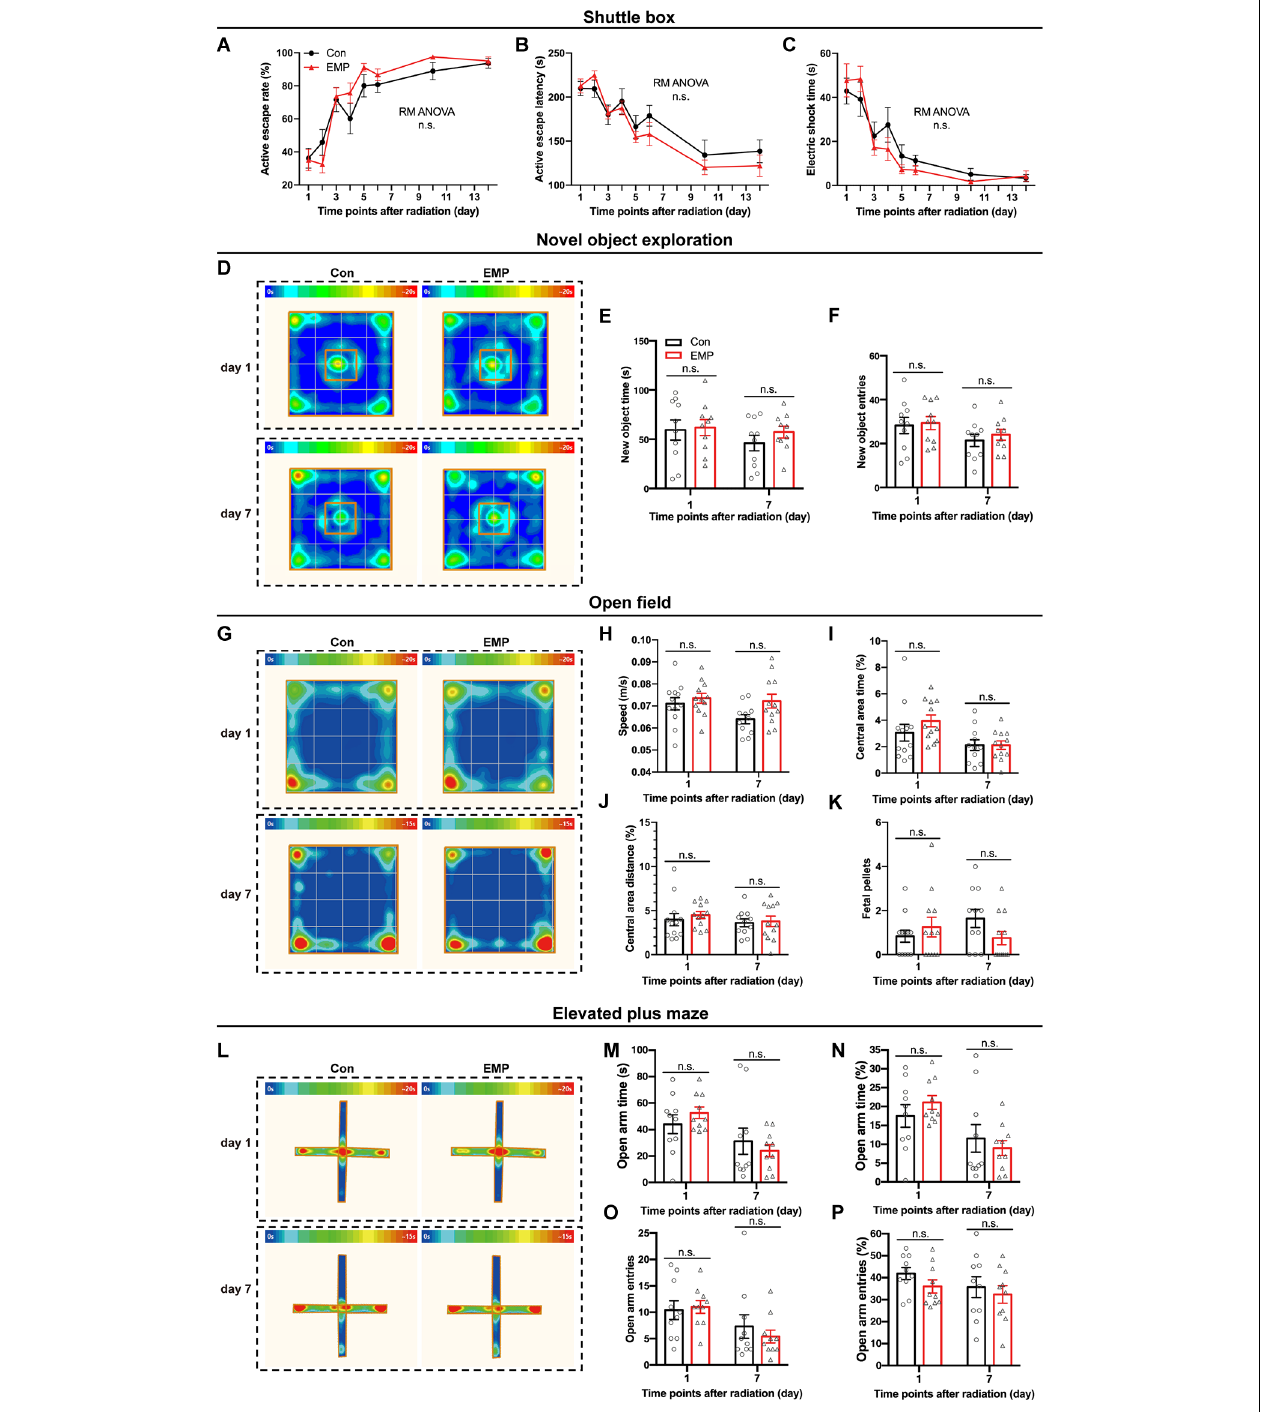
FIGURE 4 | EMPs show no significant effects on the avoidance learning, working memory and anxiety state in mice. (A–C) Shuttle box ( n = 12 mice per group), active escape rate (A) , active escape latency (B) , electric shock time (C) . (D–F) New object exploration ( n = 10 mice per group), average heat map of motion trajectory (D) , new object time (E) , new object entries (F) . (G–K) Open field experiment ( n = 12 mice per group), average heat map of motion trajectory (G) , speed (H) , central area time % (I) , central area distance % (J) , and fetal pellets (K) . (L–P) Elevated plus maze ( n = 10 mice per group), average heat map of the motion trajectory (L) , open arm time (M) , open arm time % (N) , open arm entries (O) , and open arm entries % (P) . All data are presented as mean ± SEM. Repeated-measures analysis of variance (RM ANOVA) was used to evaluate the difference between the two curves in (A–C) . Student’s t -test was used to compare the two groups (E–P) . n.s., not